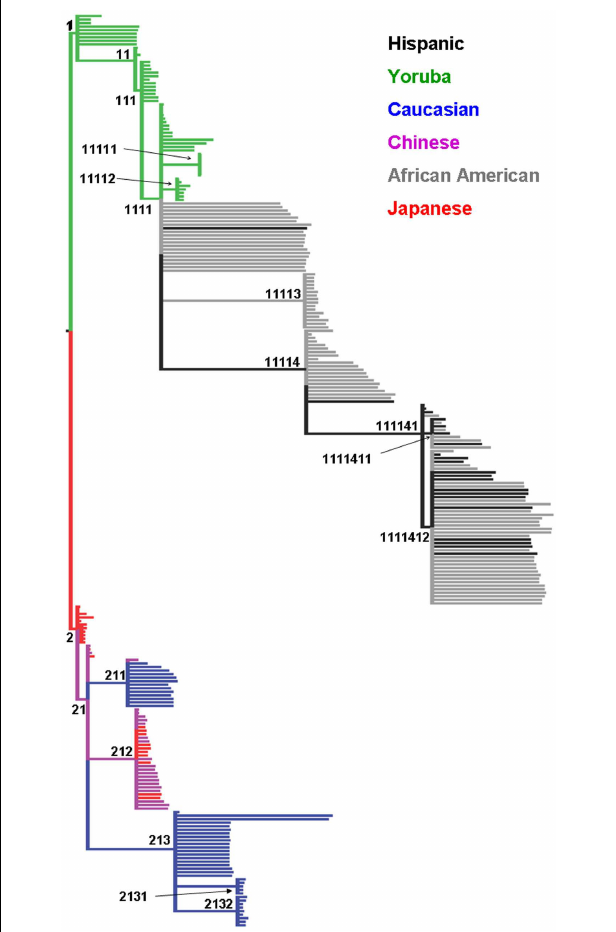
FIGURE 2 | Maximum parsimony cladogram of mitochondrial DNA (mtDNA) andY chromosome (chr:Y) single nucleotide polymorphisms. All nodes have > 70% bootstrap proportion. Unique identifiers ( n = 19) were assigned to each statistically significant node.Terminal branch tips are colored based on groupings assigned in Figure 1 using the same color coding (Green,Yoruba; Black, African-American; Red, Japanese; Purple, Chinese; Blue, Caucasian).